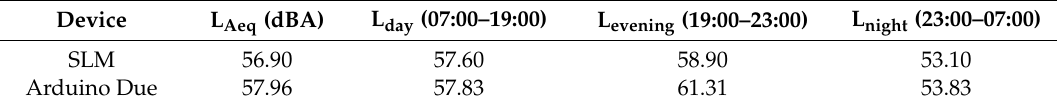
Table 7. The SLM and Arduino Due measurements in an urban street for a full day.